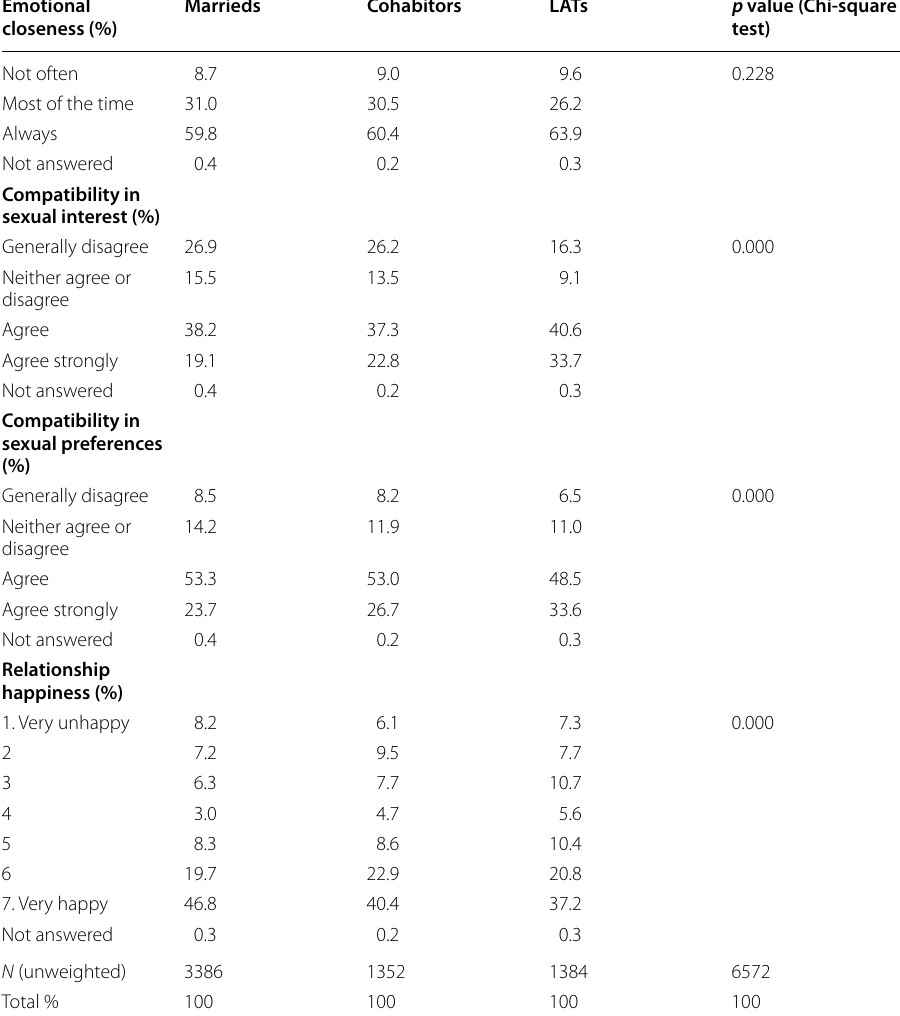
Natsal-3, own computations, weighted results; the Chi-square tests of independence (with Rao–Scott correction) suggest that there is a significant relationship between gender and the indicators for compatibility in sexual interest, and preferences, and relationship happiness at p <